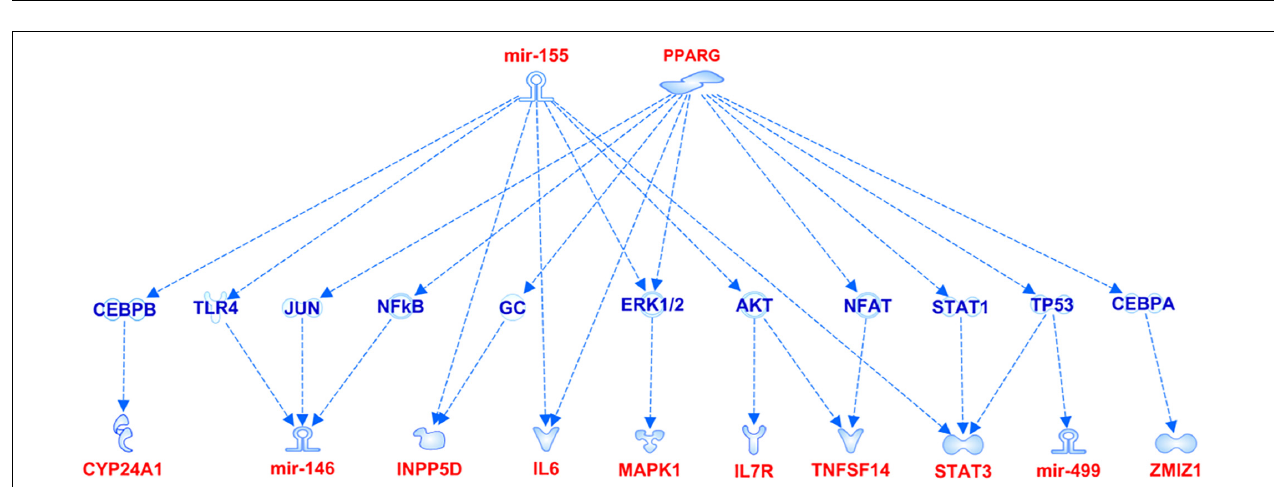
FIGURE 4 | Disease and Function Analysis for the genes associated with AD. The figure illustrates the cellular and molecular functions mainly associated with the genes of interest.